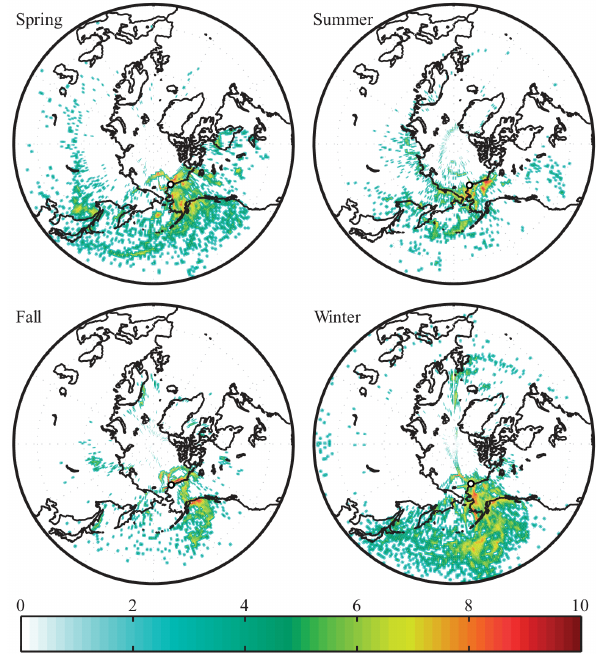
Figure 1. Spatial distribution of the vapor source region by season. Color indicates the relative frequency that a pixel was identified by HYSPLIT as a vapor source. Red indicates the most frequent va- por source for a given season, whereas dark blue indicates few air parcels were traced to that location. Because different numbers of events occurred in each season, each season’s color scale is normal- ized to the total number of air parcels tracked during that season. The figure indicates that some air parcels originate over land, but these were not included in